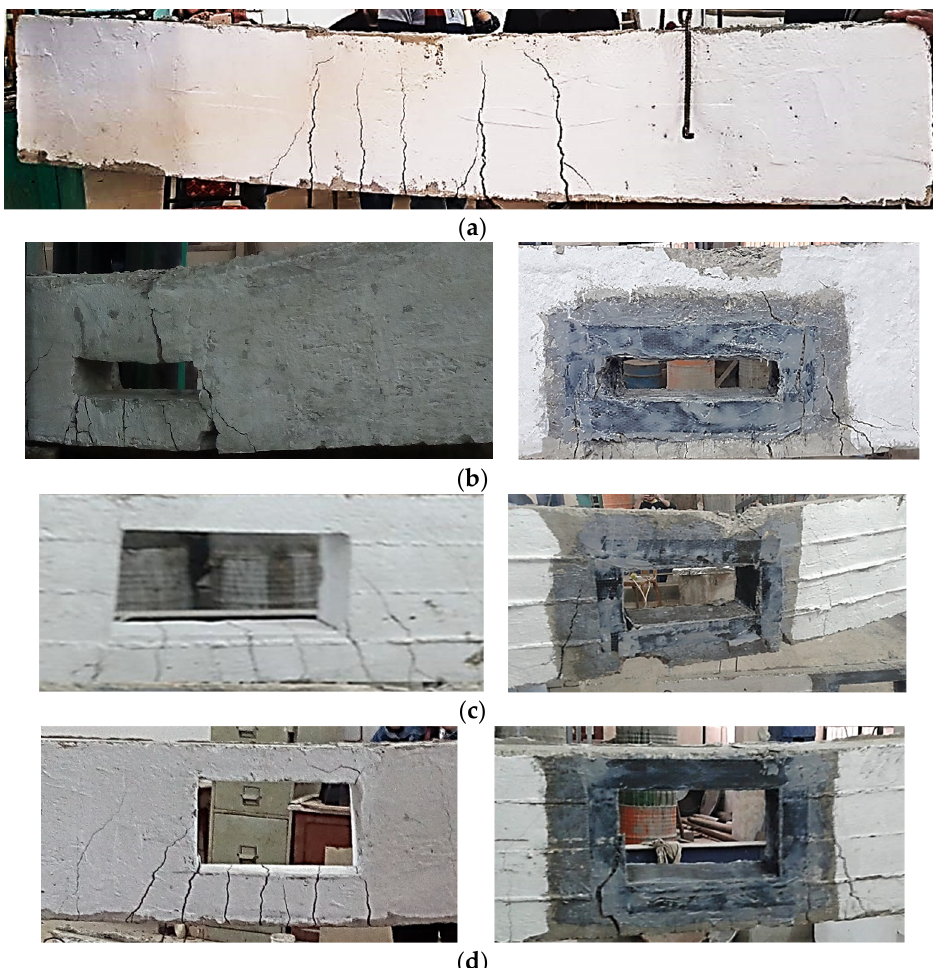
Figure 5. Failure Modes of Samples with Tension-Zone Opening. ( a )control Beam; ( b ) opening 90 × 360 mm 2 ; ( c ) opening 150 × 360 mm 2 ; ( d ) opening 210 × 360 mm 2 .